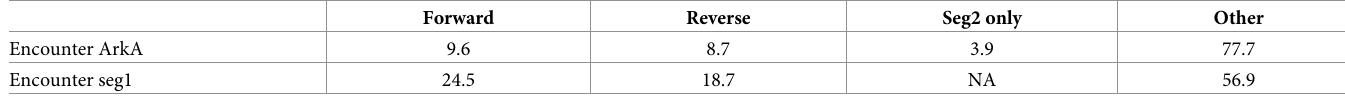
Table 3. Percentage of the encounter complex ensemble in each category for ArkA and seg1 simulations.